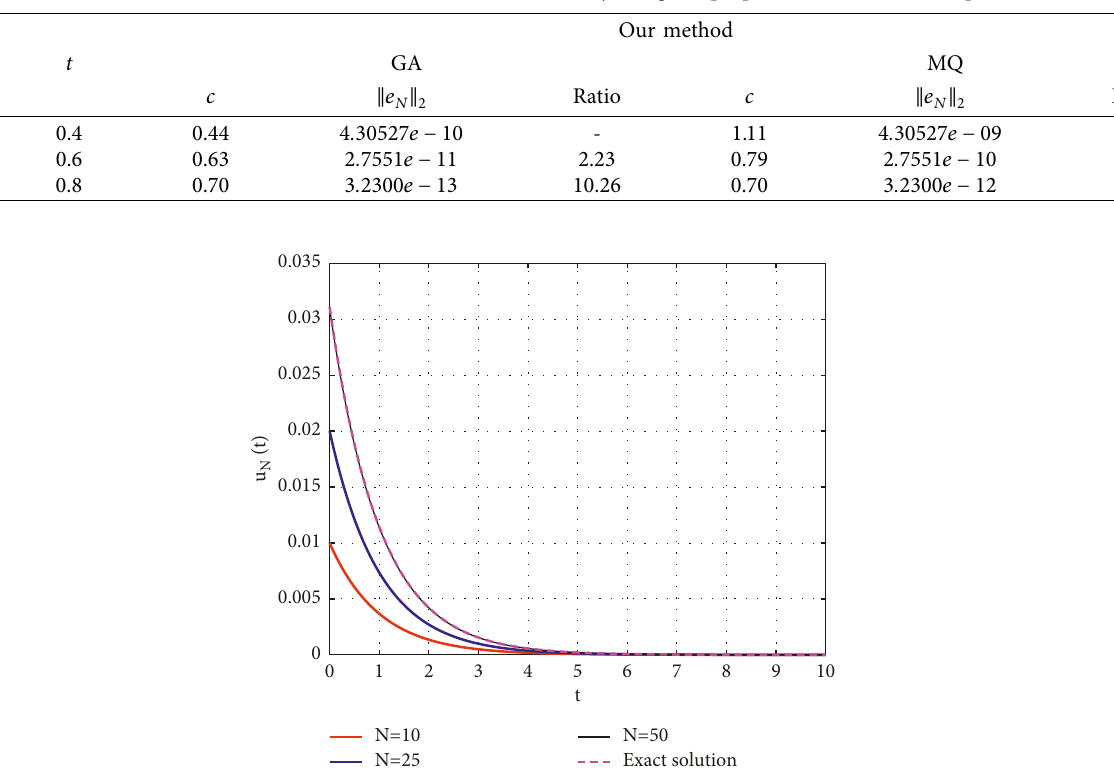
Figure 6: The graphs of the numerical solutions by using the proposed method for Example 2 with different values of N and the exact